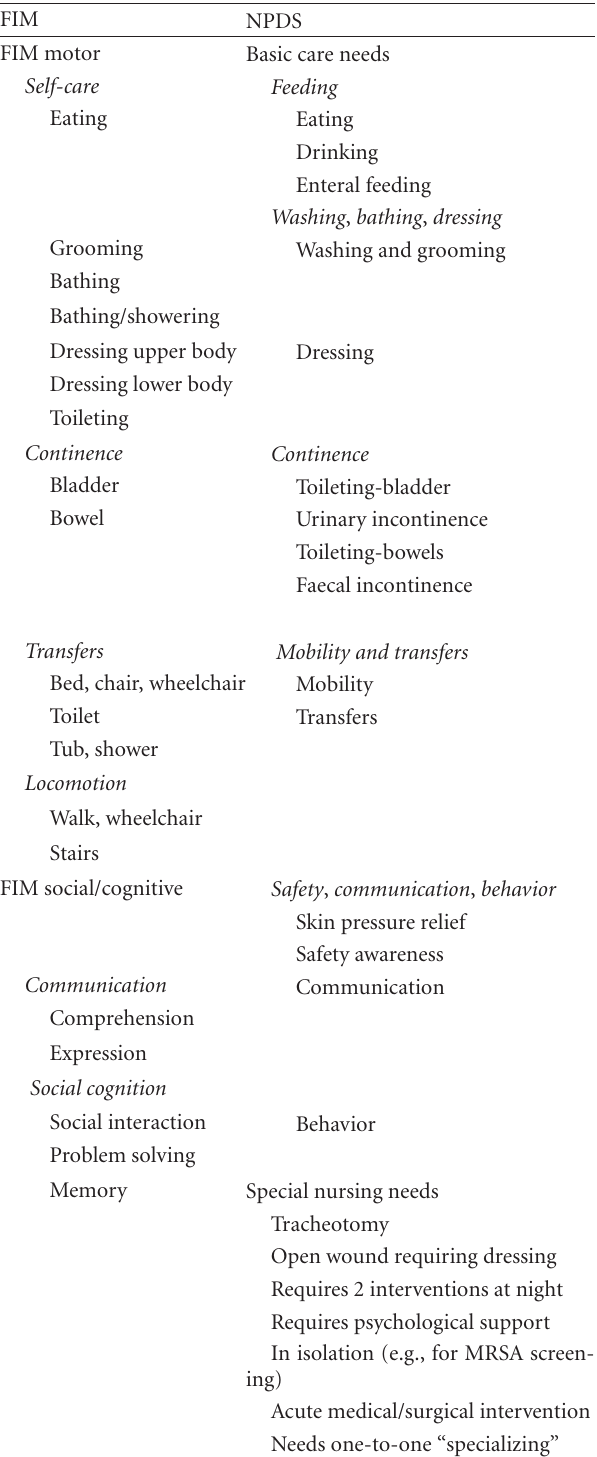
Table 4: Commonality of items in the FIM and the NPDS.